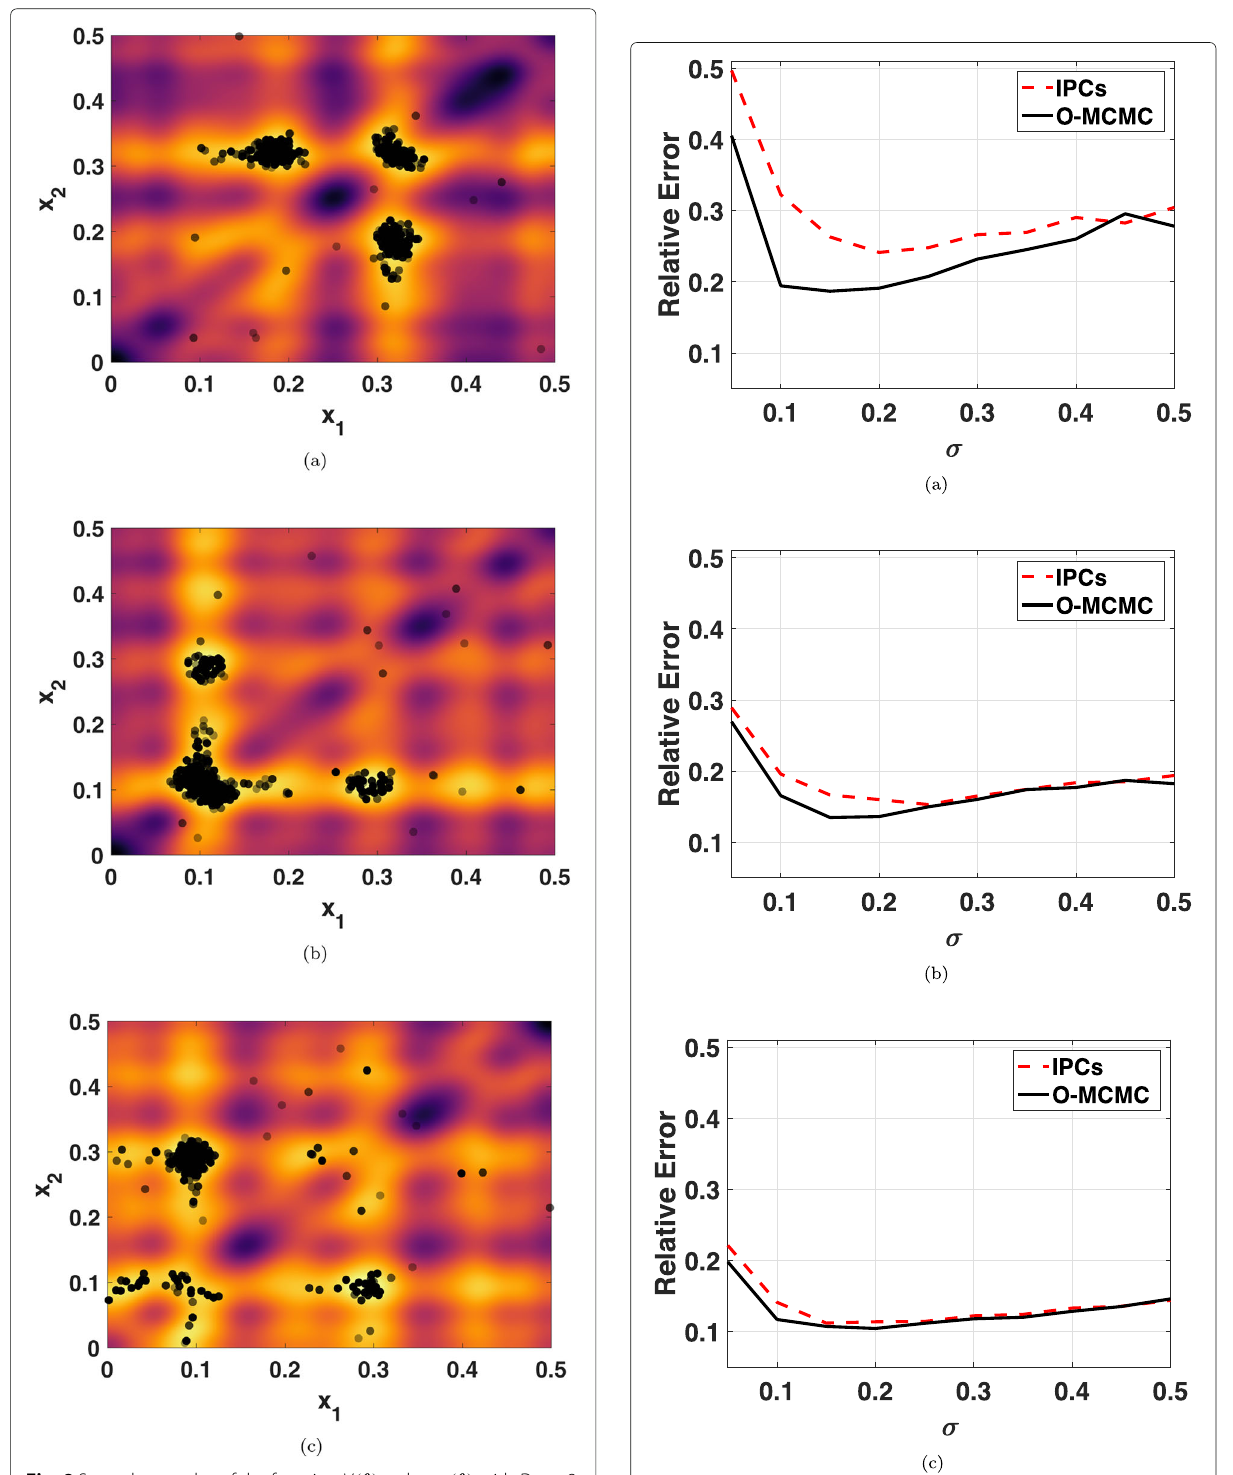
Fig. 8 Several examples of the function V ( θ ) = log π( θ ) with D θ = 2, L = 10, given different realizations of the measurements y [1], ... , y [ K ]. Black dotted points shows all the states generated throughout an O-MCMC run ( N = 10 and T = 500)